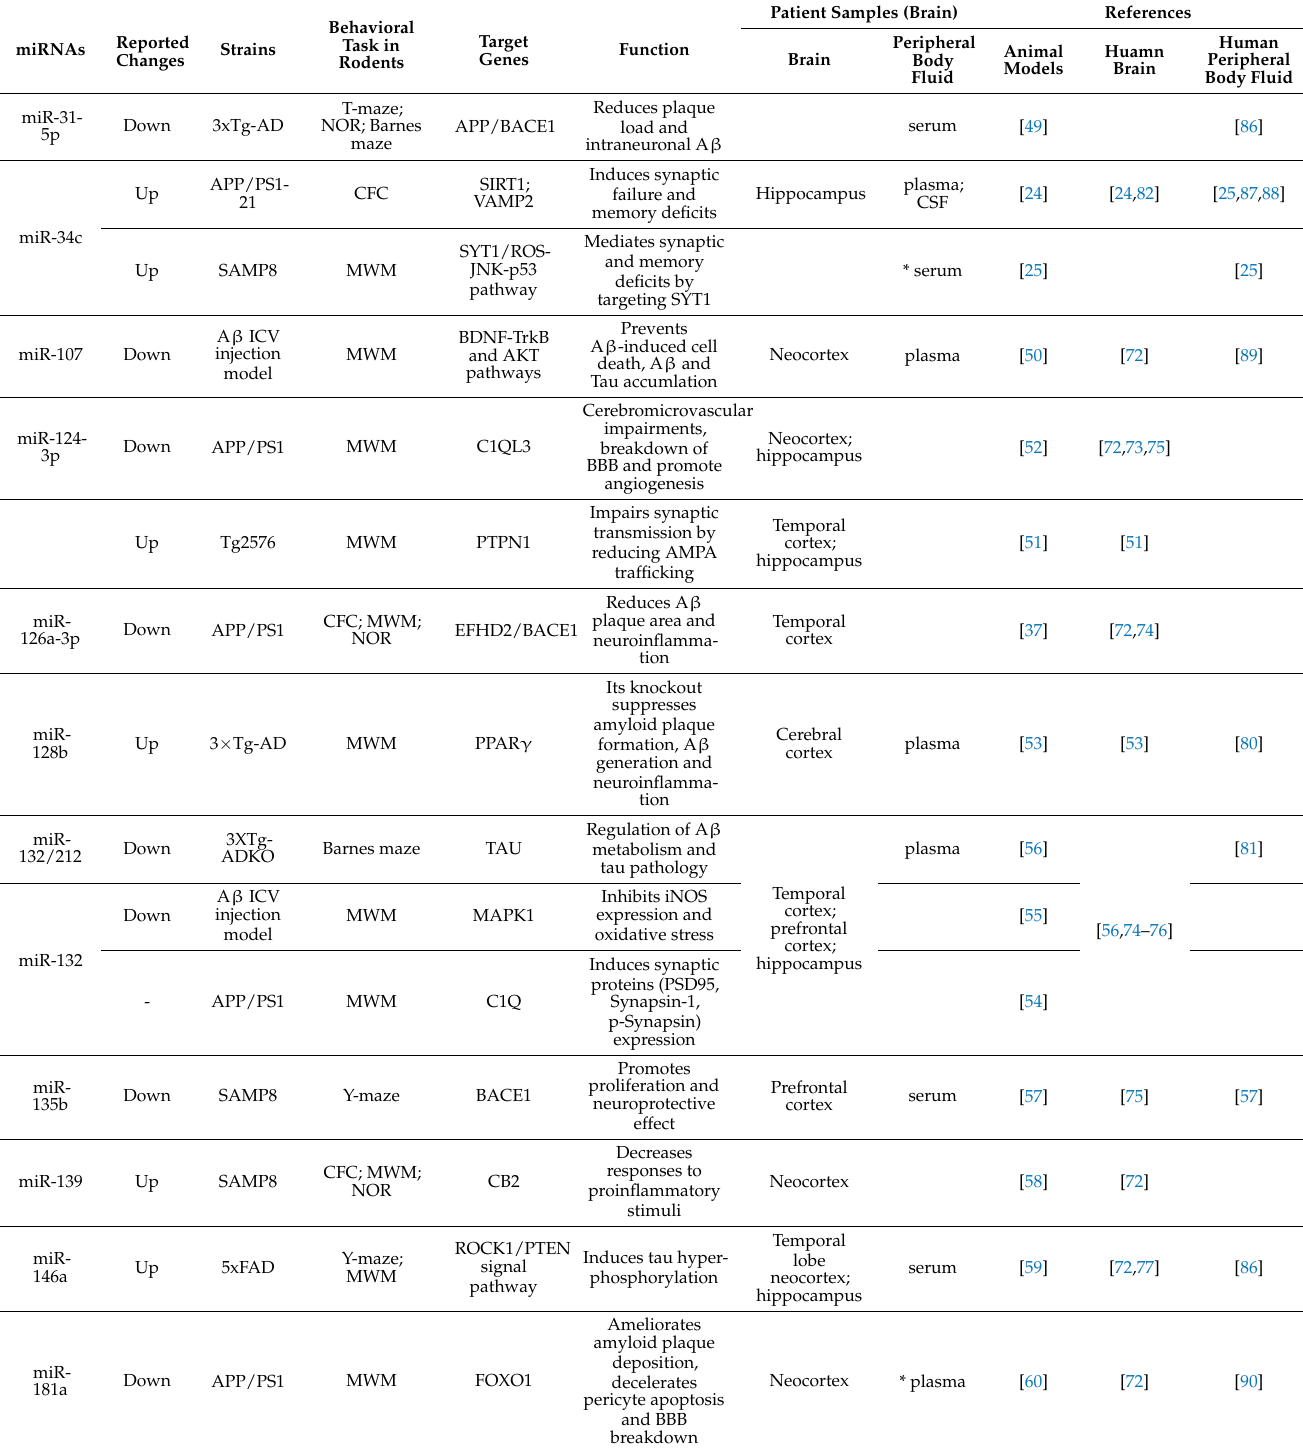
Table 3. Summary of deregulated miRNAs, target genes, and functions in AD models and locations in AD